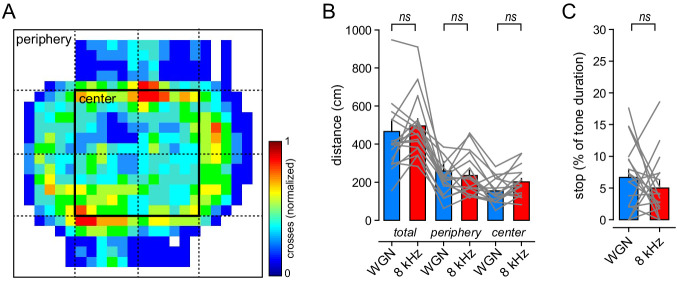
Auditory tones do not affect locomotor activity.(A) Heatmap representation of mouse activity over 12 min. Each auditory tone was presented four times for 30 s, every 10 to 60 s. (B) Averaged distance travelled (total, in the periphery, and in the center of the open field) upon WGN and 8 kHz tone presentation. Gray lines, individual mouse (n = 17). ns, non-significant, post-hoc comparison after repeated measures anova. (C) Averaged stop duration upon tone presentation. Gray lines, individual mouse (n = 17). ns, paired t-test.Figure 2—figure supplement 2—source data 1.Locomotor activity.